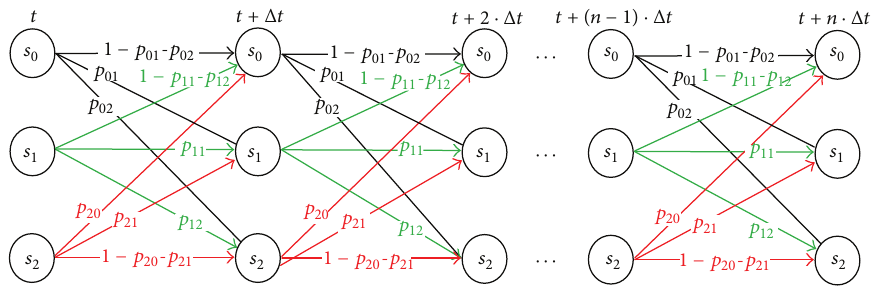
Figure 6: Model of making